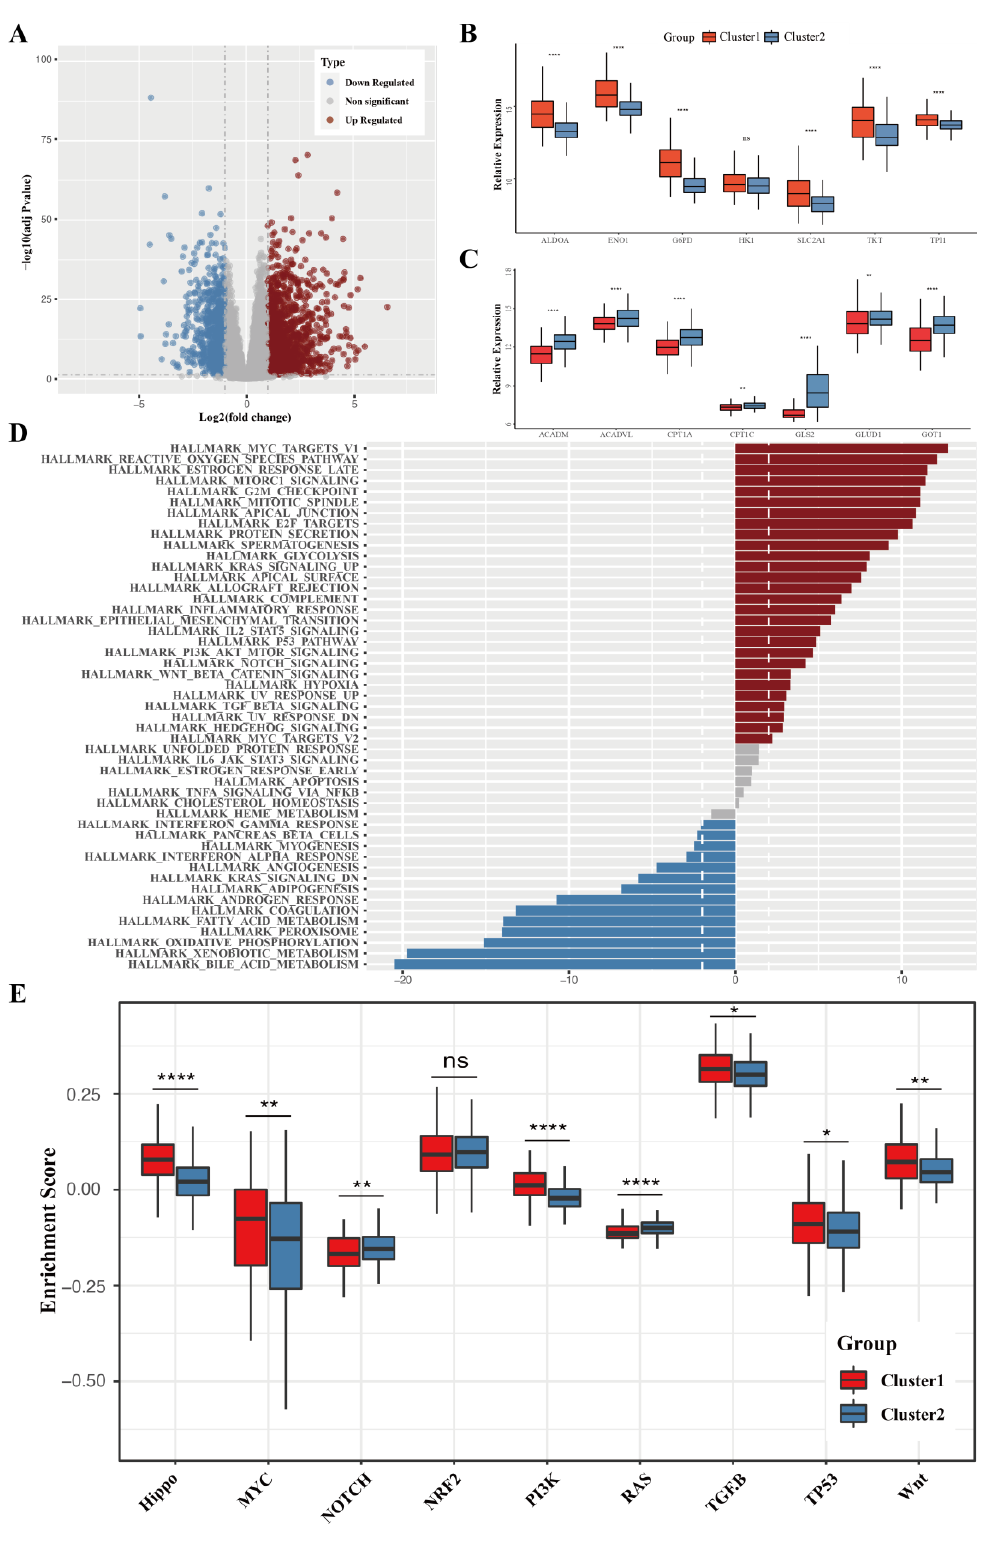
Figure 2. Distinct transcriptomic features between two liver cancer metabolic subtypes. ( A ) A volcano plot displaying differentially expressed genes in two clusters. ( B , C ) Relative expression of chosen genes of the glycolyis and PPP ( B ) and chosen genes of the FAO pathway and glutaminolysis ( C ) in the TCGA-LIHC datasets. ( D ) GSVA enrichment analysis of DEGs. ( E ) Quantification of 10 classical oncogenic pathways’ activities in two clusters. ns, p value > 0.05; *, p value < 0.05; **, p value < 0.01; ****, p value <